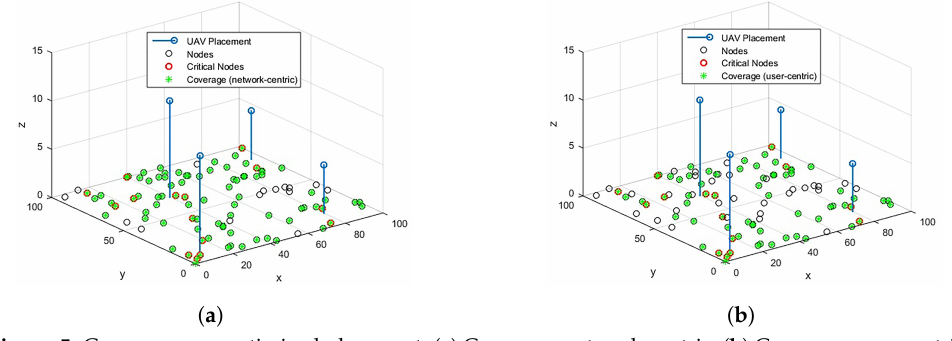
Figure 5. Coverage over optimized placement. ( a ) Coverage: network-centric. ( b ) Coverage: user-centric.